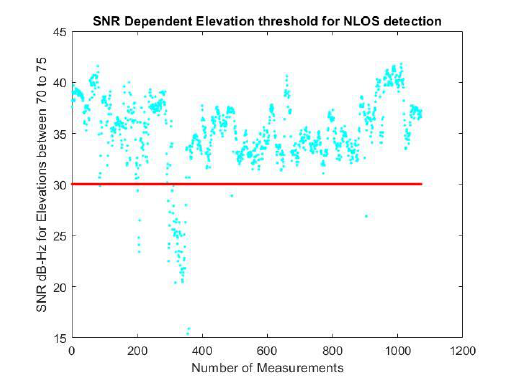
Figure 9. Elevation-dependent SNR values and applied Threshold for 70 ° -75 ° elevation binning (Cyan dots are satellites SNRs and red line is SNR threshold in 70 ° -75 ° elevation bin, this threshold is chosen using the average of the SNRs in each height bin minus